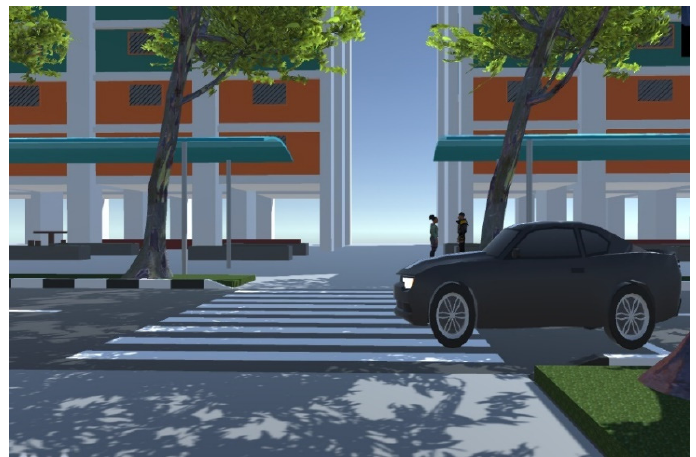
Figure 5. Game scene of the zebra crossing.